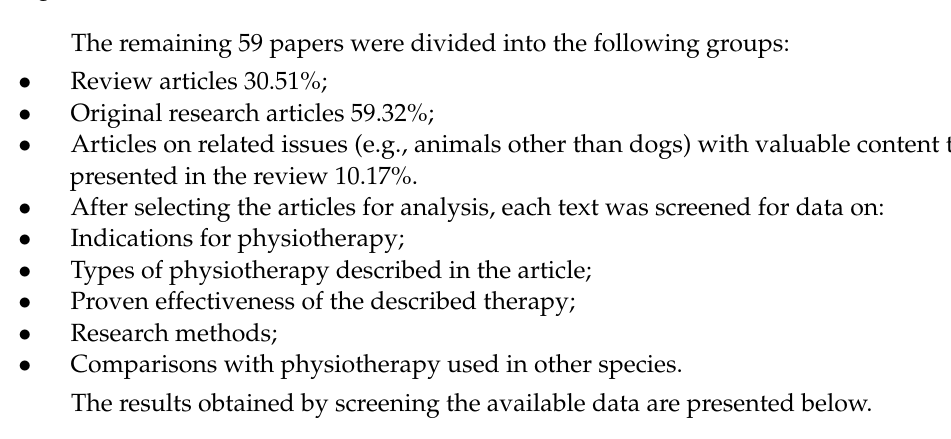
Figure 1. Selection of articles.